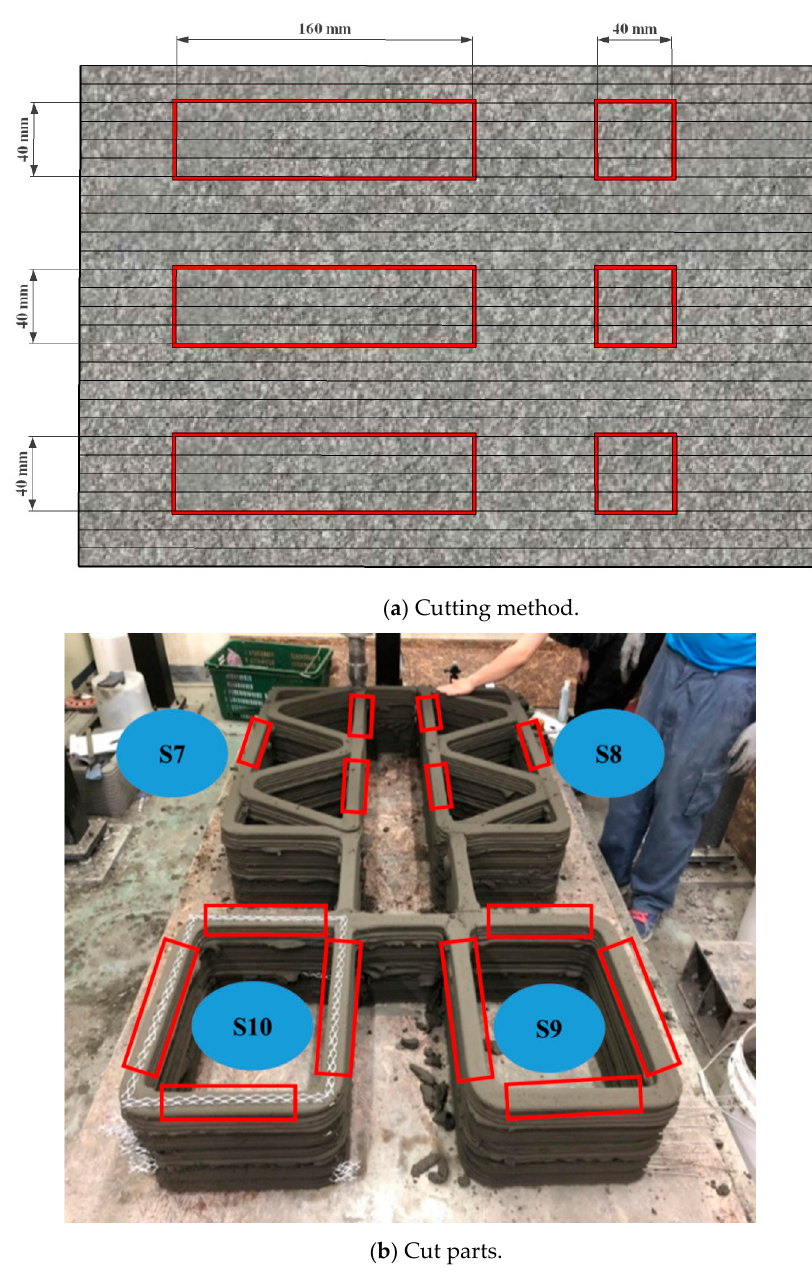
Figure 6. Typical representation of specimen cutting from a 3D printed concrete wall.